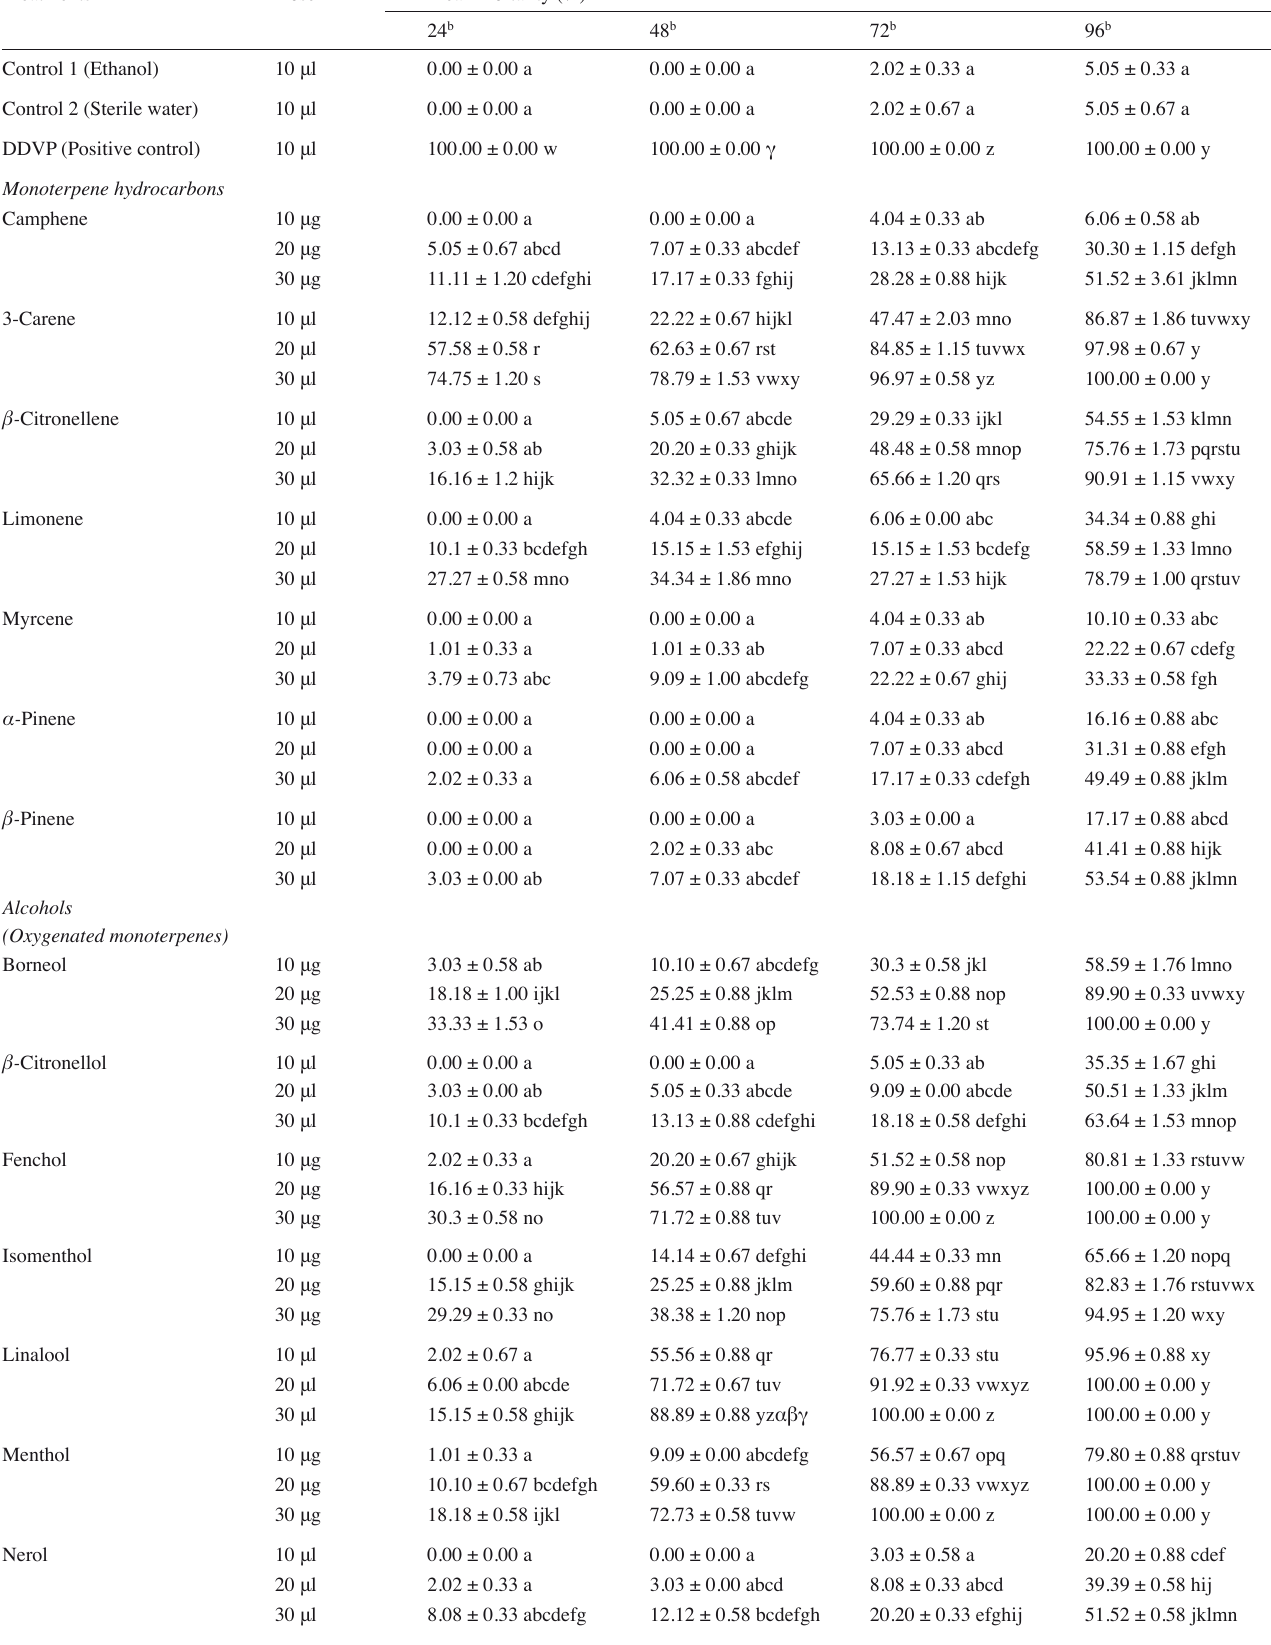
Tab. 1: Percent mortality effects of twenty eight monoterpenes to adults of Sitophilus